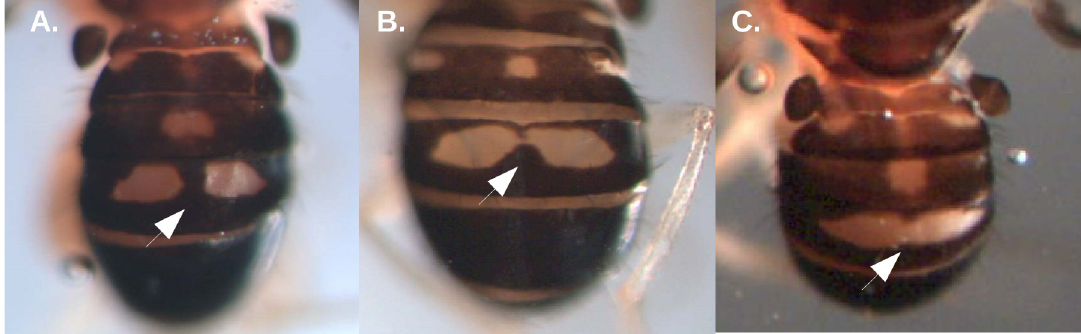
Fig 2. Abdominal coloration (dorsal view) of the different species of the M . projectans complex, as visualized in a stereomicroscope. (A) Pattern A1, presenting two individual light spots in tergite IV; (B) Pattern A2, presenting two confluent light spots, that are narrowed in the median region, (C) Pattern B, presenting confluent light spots, without the narrowing in the median region. Patterns A1 and A2 are seen in M . projectans affinis 1 and M . projectans affinis 3, whereas pattern B is exclusive of M . projectans affinis 2. Image (A) of sample 577A109, (B) of sample 581A26 and (C) of sample 577A88 (see S7 Table for more details).